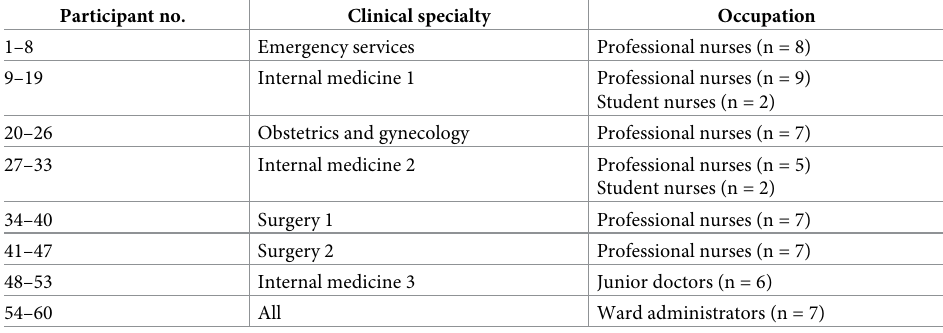
Table 1. Participant numbers and characteristics (medical module and occupation).